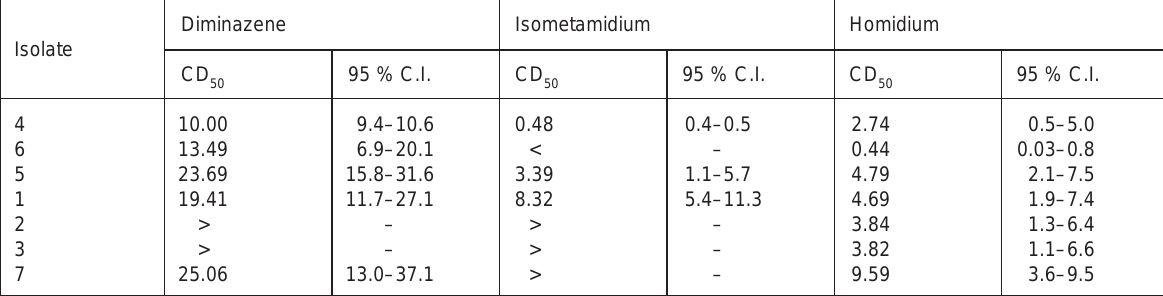
Number of mice positive per isolate